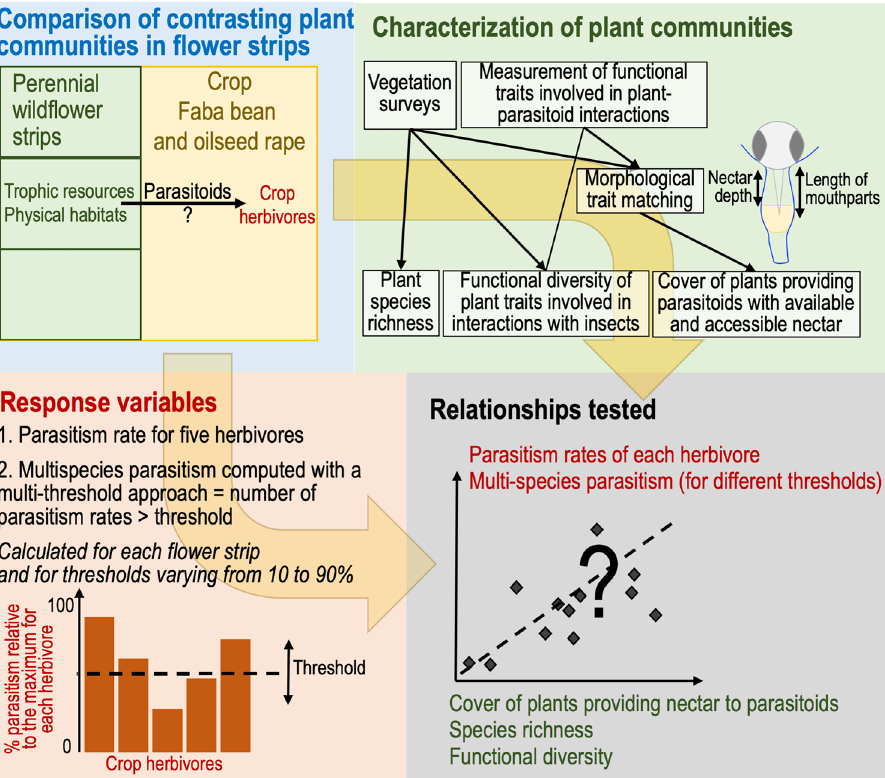
Figure 1. Graphical abstract of the main experimental and methodological approaches used in this study. This figure was created using Microsoft Powerpoint version 16.16.14 (https:// www. micro soft.